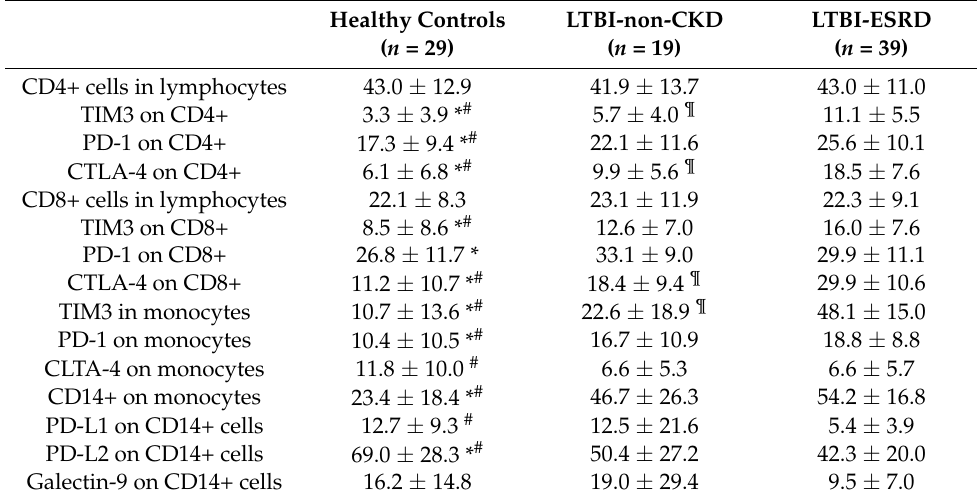
Table 2. Immune checkpoints and immune cell proportions according to status of latent tuberculosis infection and renal function. The data are shown in percentage.